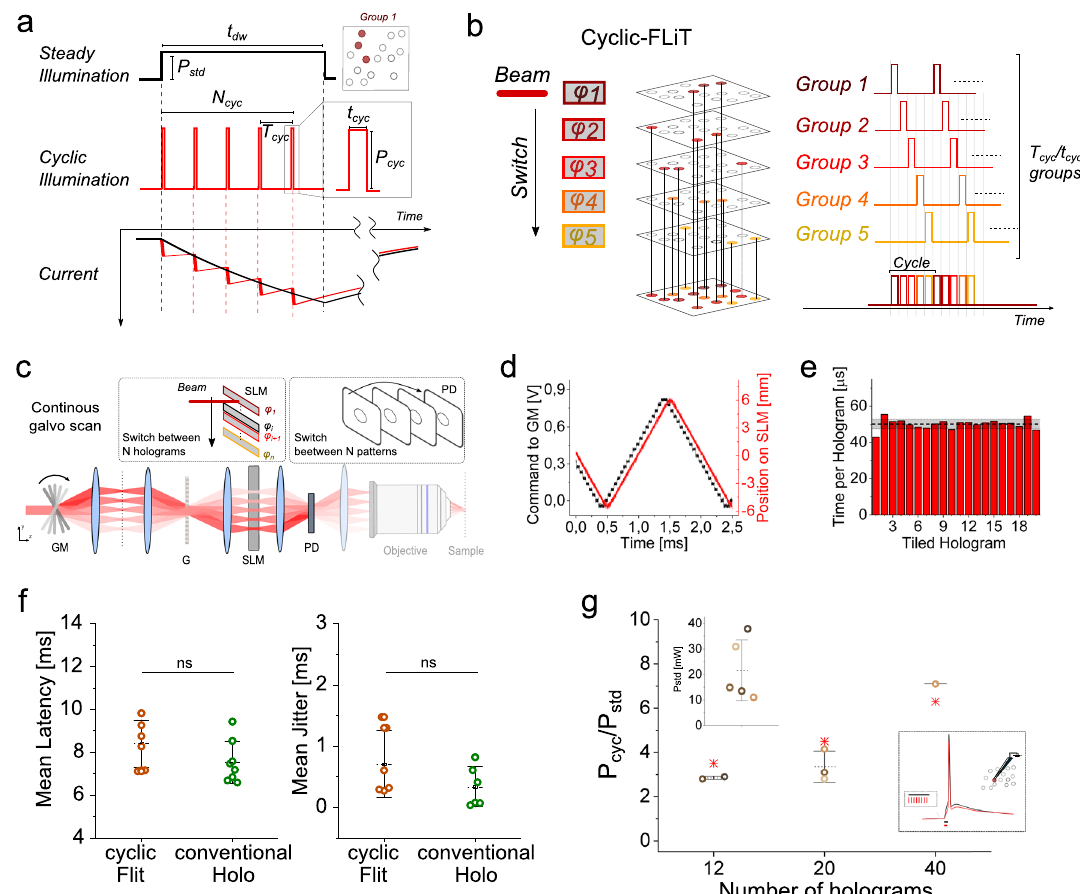
Fig. 3 | Photoactivation under cyclic- FLiT. a Photostimulation of a group of neurons under steady and cyclic -illumination. A soma-targeted light pattern enco- ded by a single hologram can be used to photoactivate a group of neurons either under steadyilluminationof power P std and duration t dw (black line, top)orunder cyclic -illumination of N cyc pulses at power P cyc , period T cyc and pulse duration t cyc (red line, middle). Simulated photocurrents generated in a ST-ChroME-expressing neuron are shown under steady (black, bottom) and cyclic (red, bottom) illumi- ffiffiffiffiffiffiffiffiffiffiffiffiffiffiffiffiffiffi q ffiffiffiffiffiffi p ( P std =0 : 05mW/ µ m 2 ; P cyc =0 : 05 20 mW/ µ m 2 ; nation when P cyc = P std T cyc = t cyc T cyc =20 t cyc ; t cyc =50 μ s; 1030nm). b Conceptual scheme of simultaneous photo- stimulation of multiple groups of neurons under cyclic -FLiT. The LC-SLM is tiled in multiple holograms φ i (here from φ 1 to φ 5 ) each encoding for distinct soma- targeted multicell light patterns encoding for different groups of cells (here from Group 1 to Group 5). The illumination beamisswitched across the hologramssuch that the light is sequentially redirected to H =1/D holograms, and the same cyclic photoactivationprocessisenabledsequentiallyonthedifferentlightpatterns.The scheme displayed is meant to represent H groups of spots; their number is here limited to 5 for presentation purposes only. c Measurements ofthe switching time tosequentiallyilluminateallhologramsatconstantratefrom φ provided as a Source Data fi